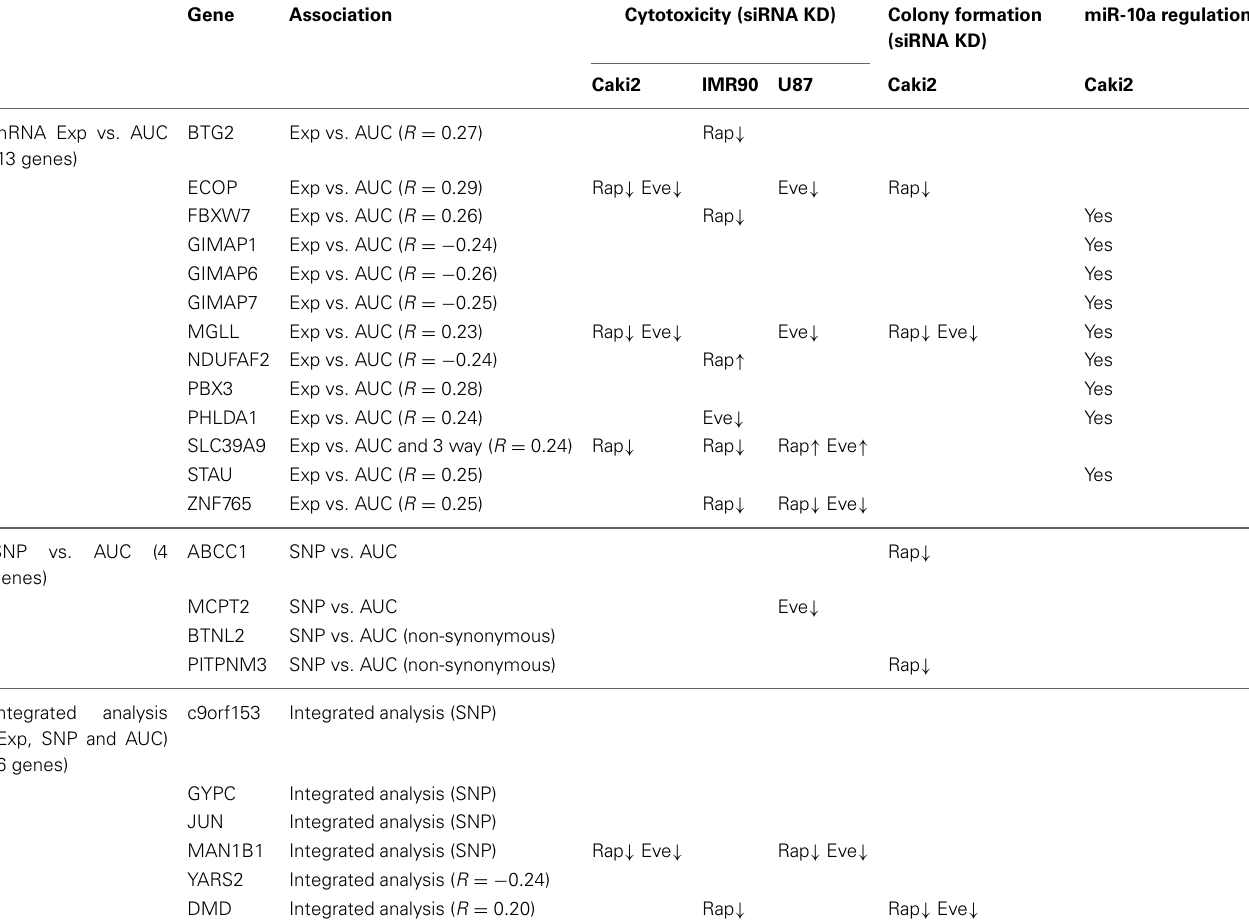
Table 2 | Summary of functional validation of candidate genes.